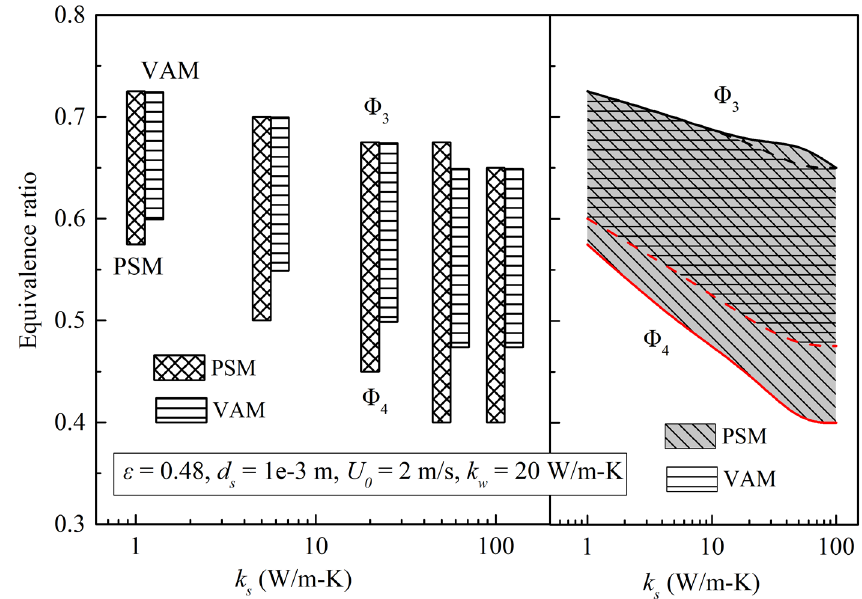
Figure 11. Effects of k s on the flame stability limits obtained by the PSM and VAM.